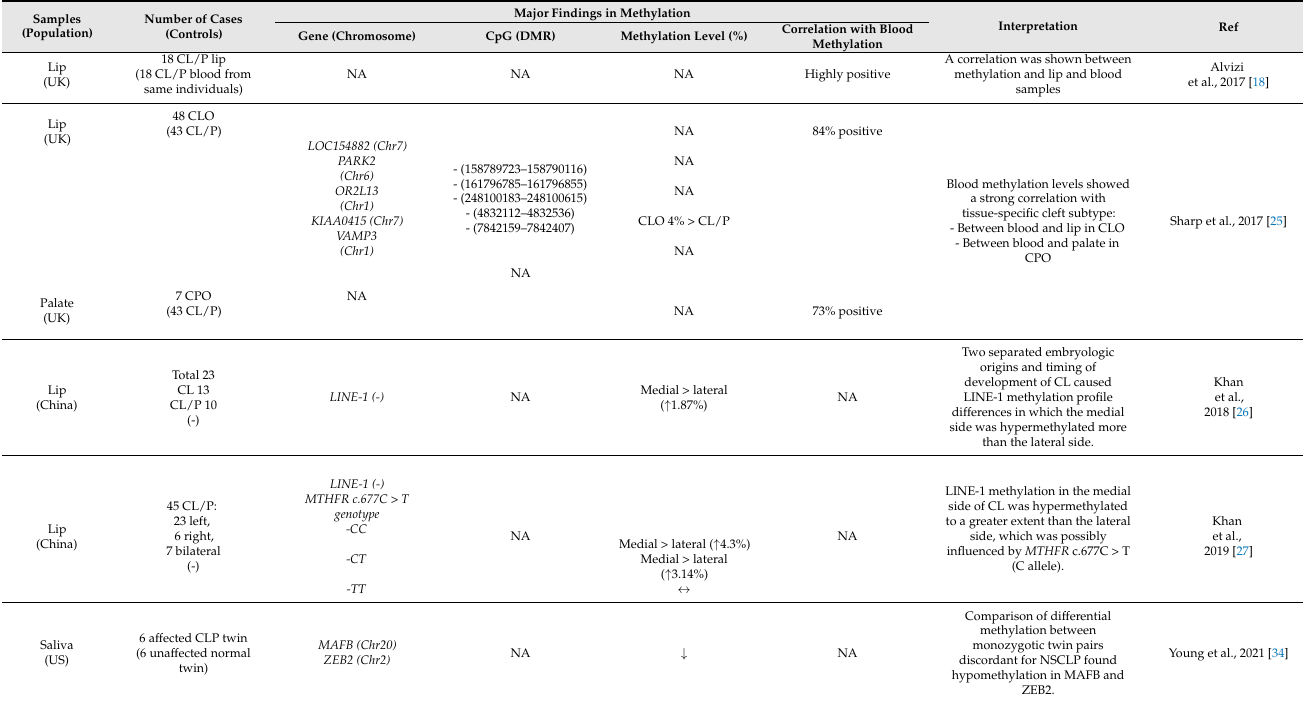
Table 2. Alterations in DNA methylation found in lip, palatal tissue, and saliva of patients with an orofacial